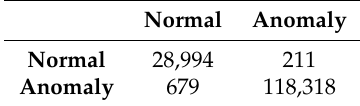
Table 17. Confusion matrix for Bagging Random Forest.